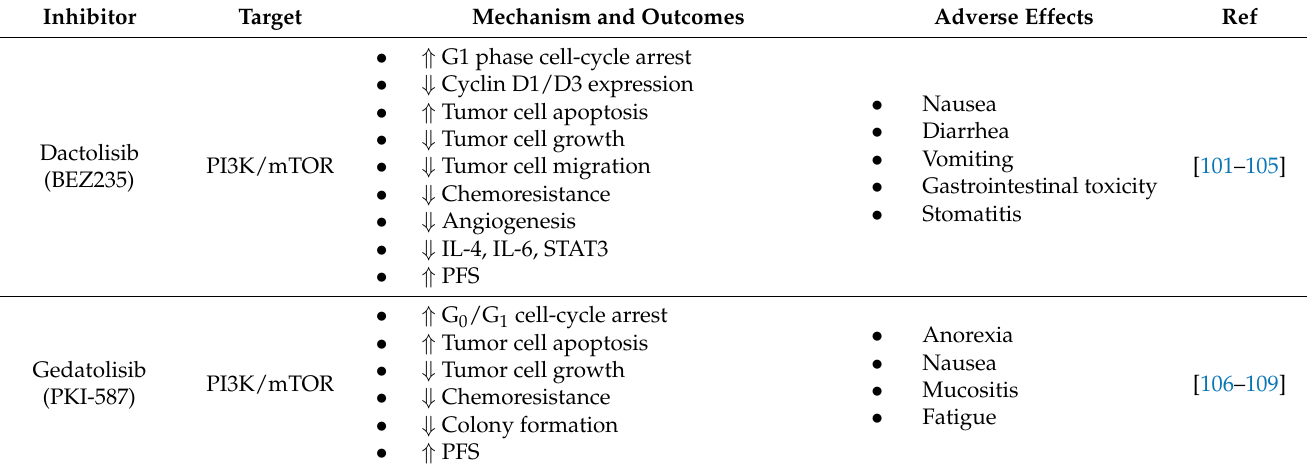
Table 1. List of the most important dual pathway inhibitors. Inhibitor Target Mechanism and